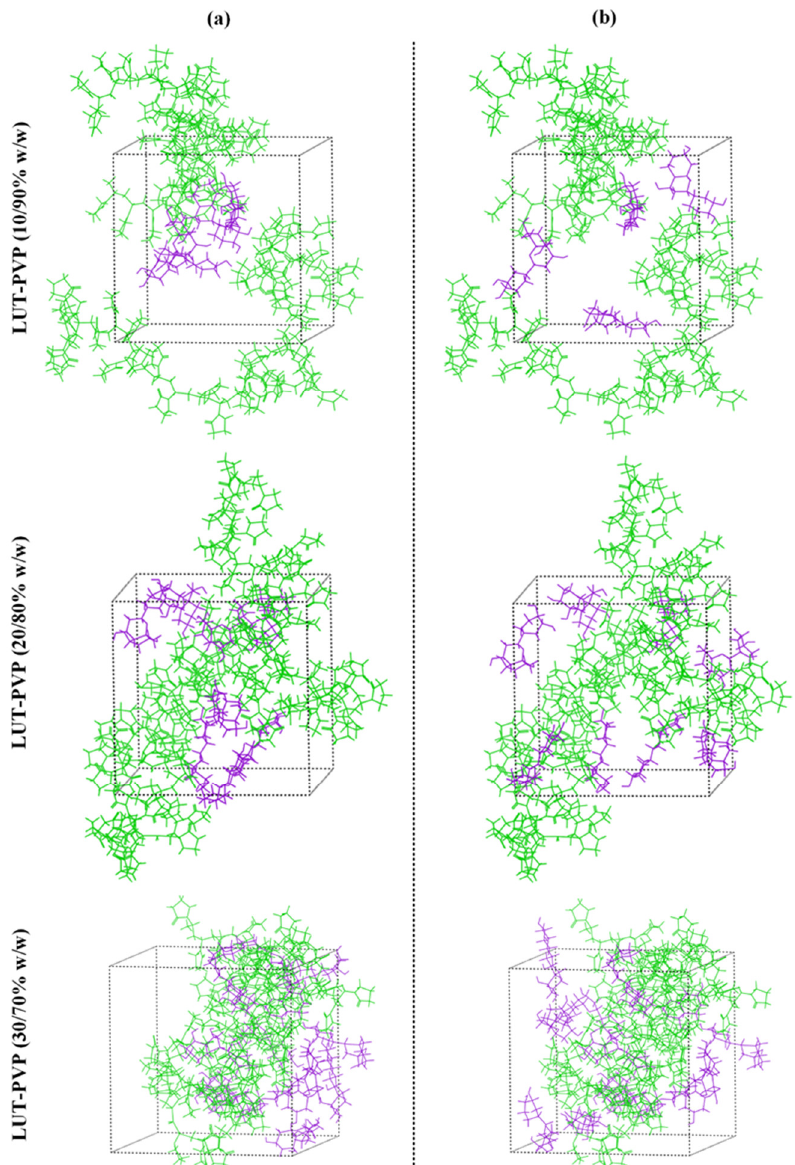
Figure 7. MD simulation boxes ( a ) before and ( b ) after the adopted equilibration protocol (PVP chains with green; LUT molecules with purple).